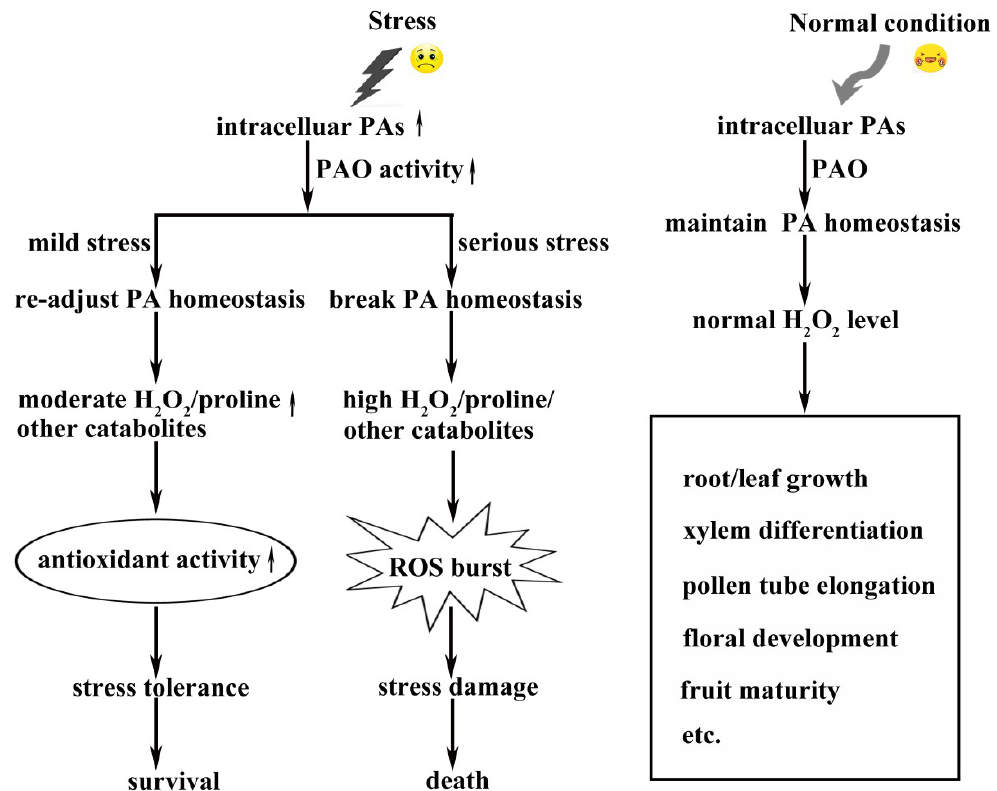
Figure 5. Diagrammatic representation of the roles of PAO involved in developmental growth and environmental stress response in plants. The thick upright arrows indicate increase in the activity or concentrations. The cartoon pictures of smiling and bitter faces indicate the plant growth under normal or stress conditions, respectively. ROS: reactive oxygen species.